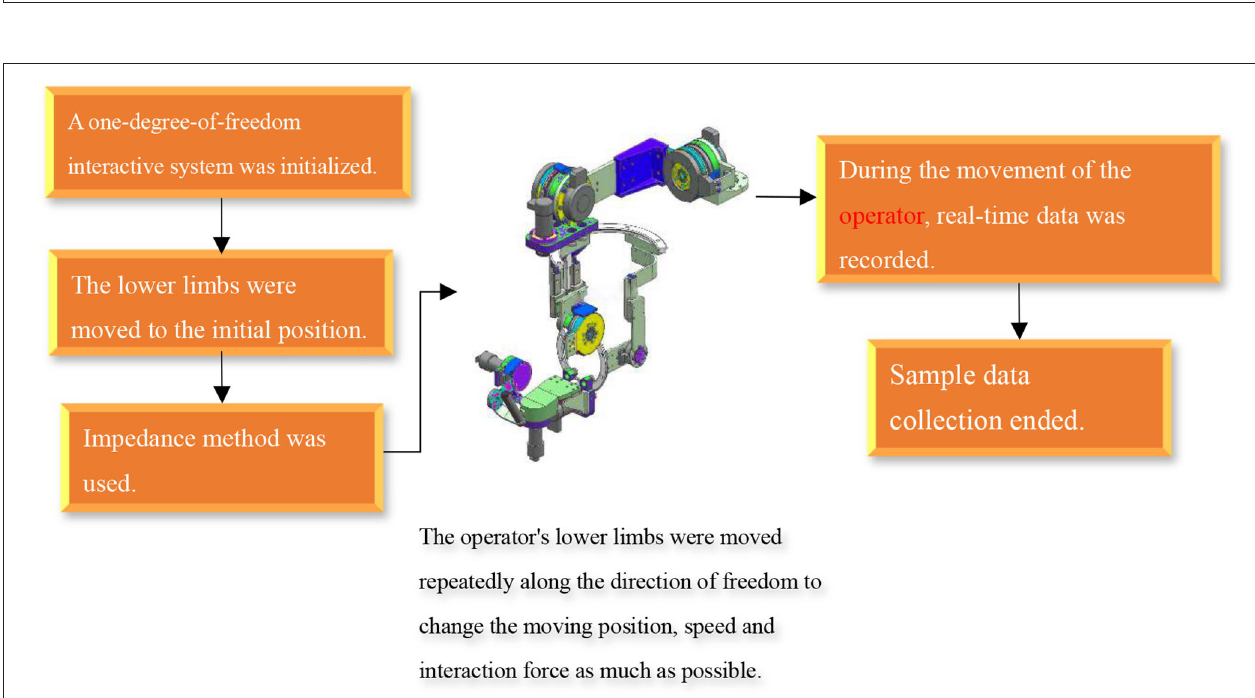
FIGURE 6 | Hardware structure of the human–machine coordinated motion experiment system.